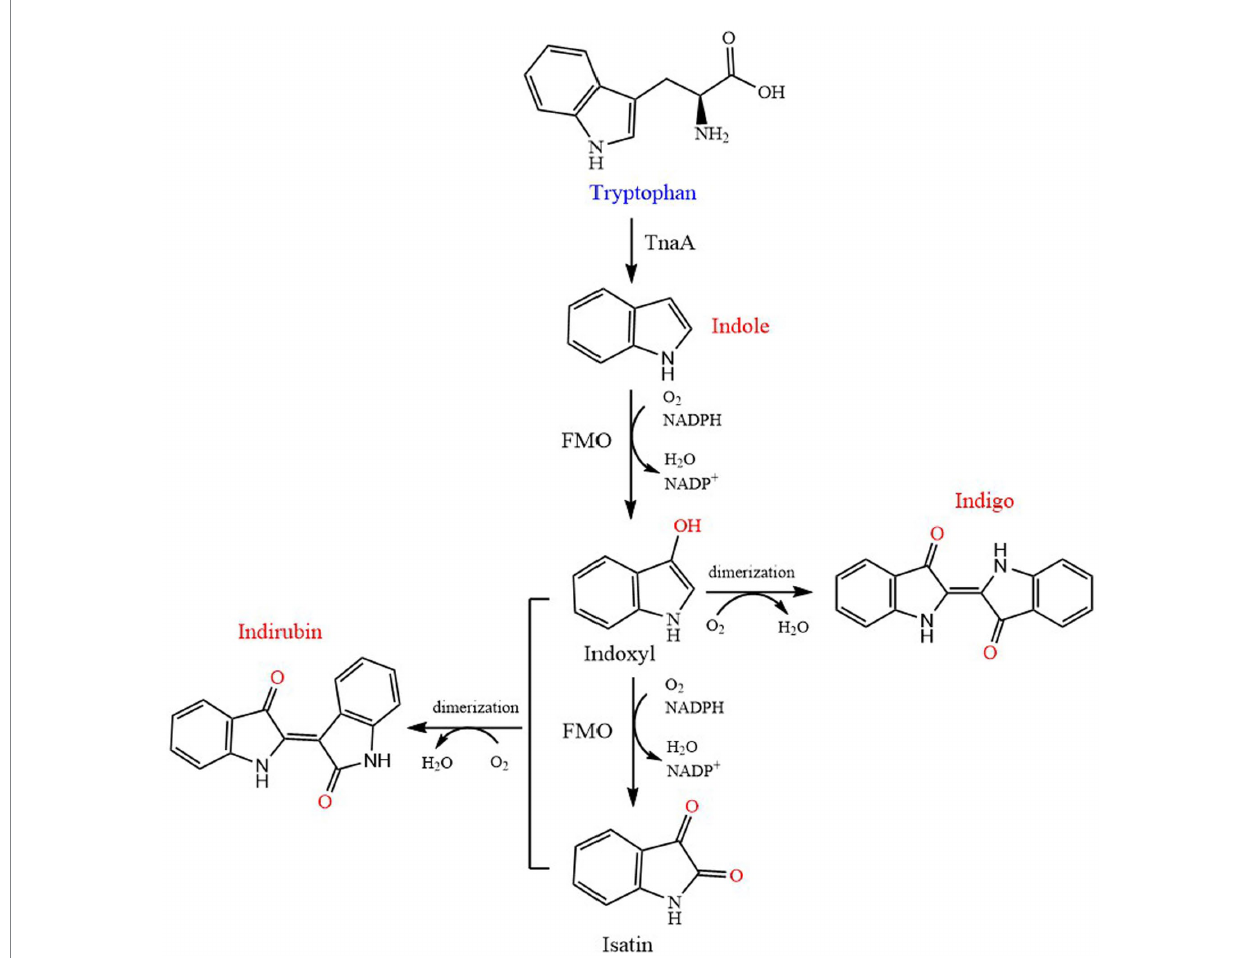
FIGURE 4 Biosynthetic pathway of indole, indigo and indirubin. TnaA, tryptophanase; FMO, flavin-containing